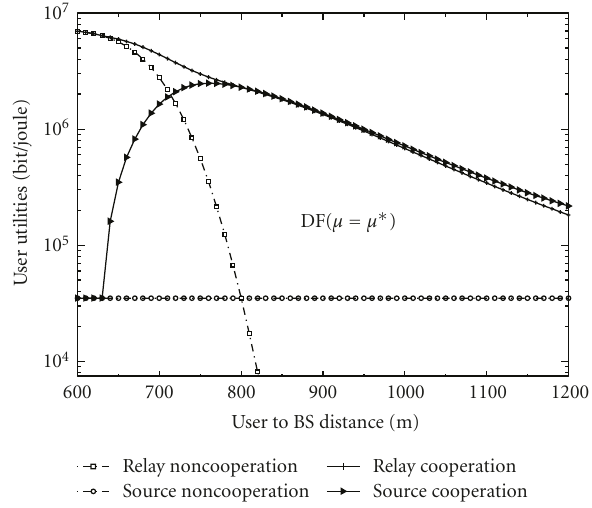
Figure 4: User utilities with the proposed strategy under DF forwarding.